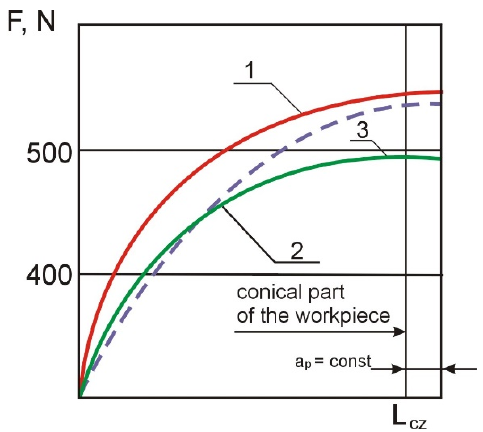
Figure 8. Curves of cutting forces vs. machining time: 1—without the use of electro-contact heating; 2—with the use of electro-contact heating; 3—with the use of the electro-contact heating control system.